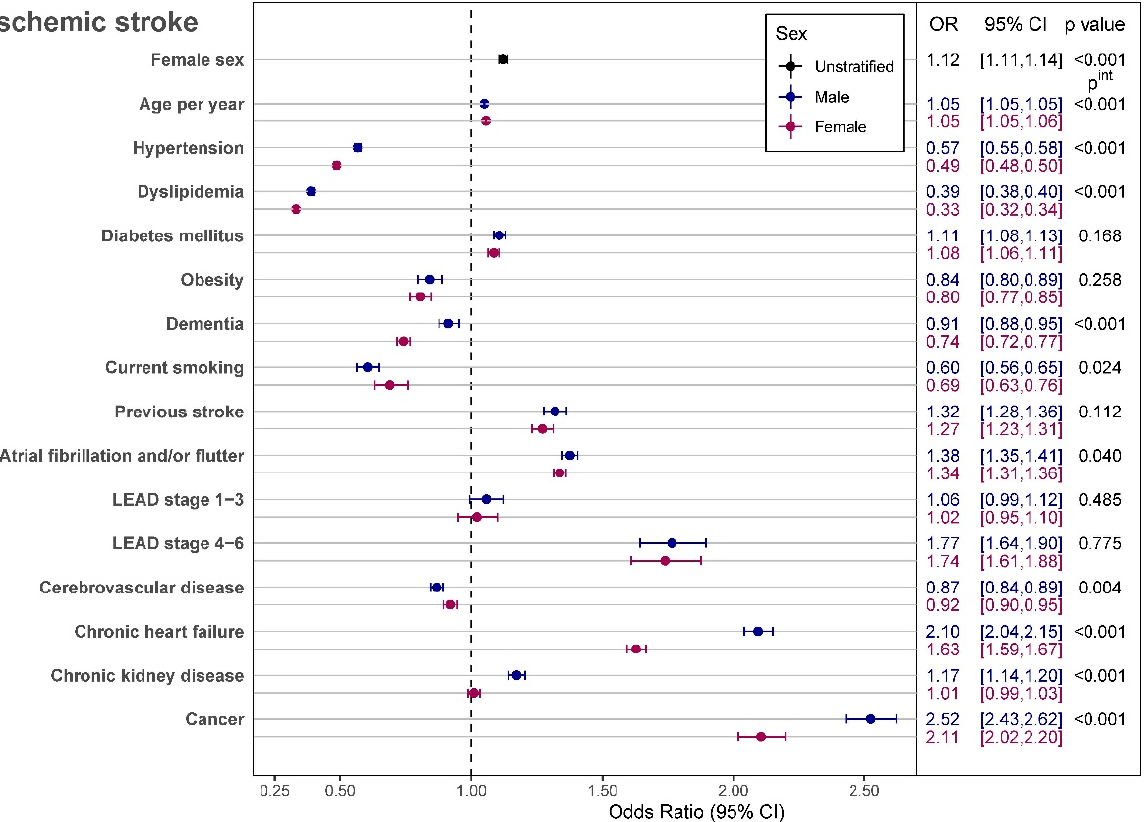
Figure 2. Forest plot of a multivariable logistic regression analysis for ischemic cerebral infarction from 2014 to 2019, evaluating the association of sex and in-hospital death. Data were adjusted by patients’ age and risk profile. The analysis included the following secondary diagnoses: hypertension, dyslipidemia, diabetes mellitus, obesity, dementia, current smoking, previous stroke, atrial fibrillation and/or flutter, lower extremity artery disease, cerebrovascular disease, chronic heart failure, chronic kidney disease, cancer. LEAD denotes lower extremity artery disease.